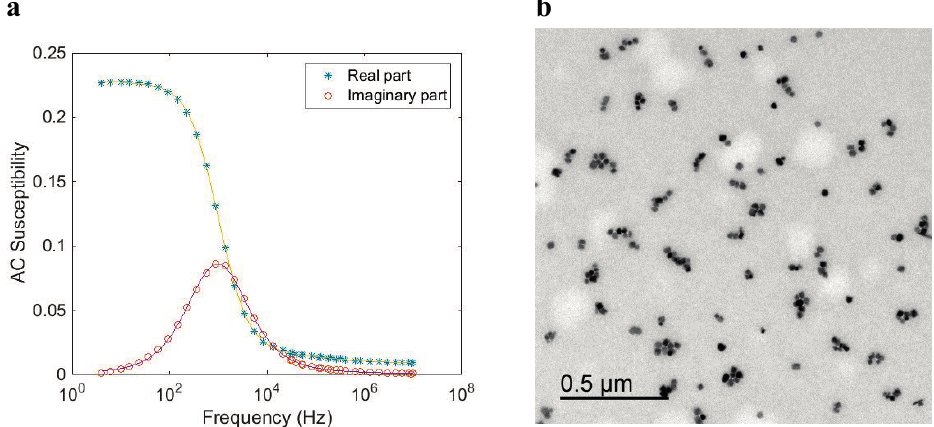
Figure 6. ( a ) AC susceptibility vs. frequency at room temperature of a magnetic single-core particle system ( CSIC04 ) that shows Brownian relaxation (particles dispersed in water). The solid line in the figure is from the fitting procedure to the single-core model; ( b ) TEM image of the particle system.